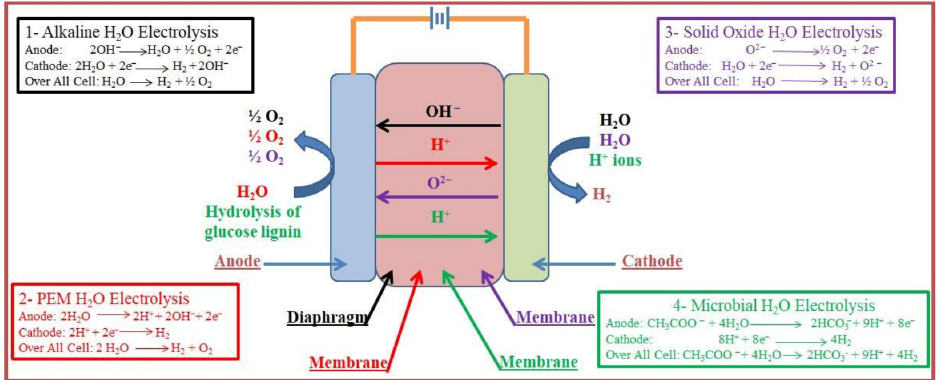
Figure 3. Schematic representation of the different H 2 O electrolysis techniques. Note: the different colors correspond to the four different types of H 2 O electrolysis cells: (1) black color for the alkaline electrolysis cell; (2) red color for the PEM electrolysis cell; (3) purple color for the solid oxide electrolysis cell; (4) green color for the microbial electrolysis